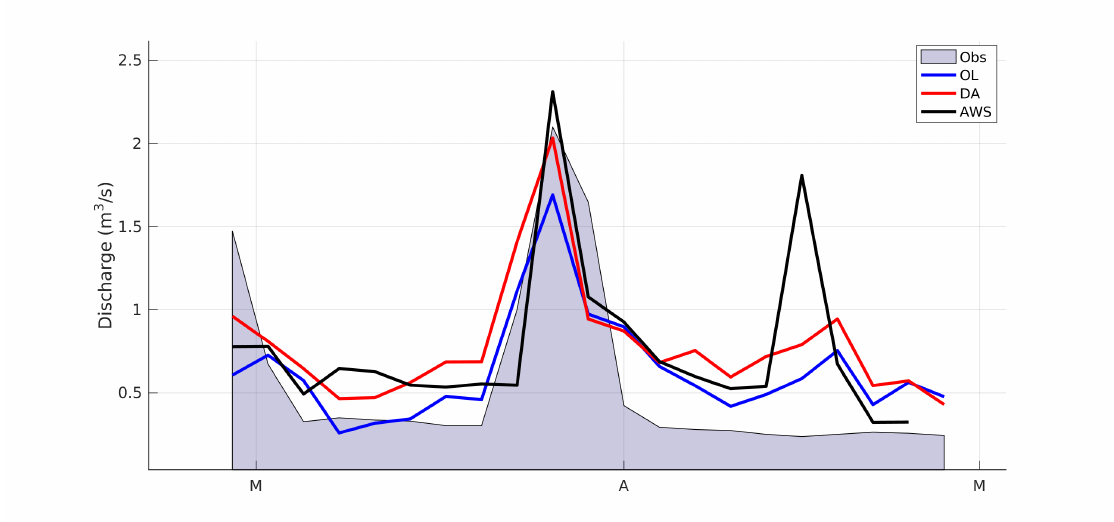
Figure 10. Comparison of the simulated and observed discharge at Tahanaout (see Section 3.1). OL: open loop discharge, DA: data assimilation discharge, AWS: modeled discharge by using automatic weather stations